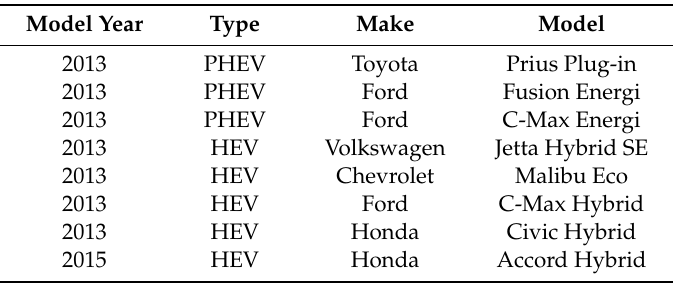
Table 2. List of vehicles used for the e ff ect of ambient temperature on fuel economy and kinetic energy recovery by regenerative